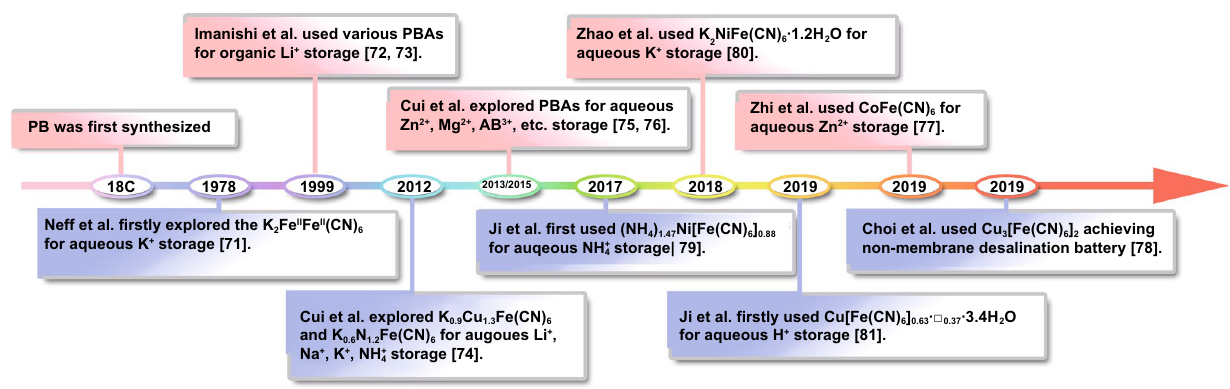
Fig. 1 A summary of the key milestone in the development of PBAs used as electrode material in aqueous batteries